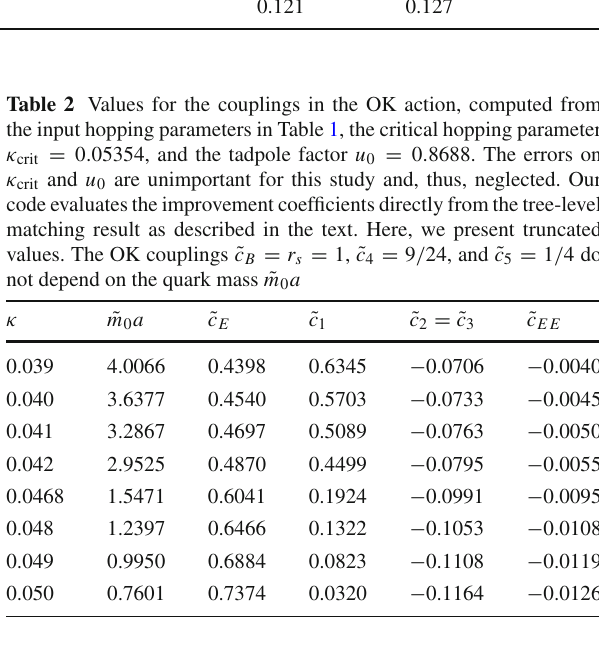
at this lattice spacing, falling in two regions, referred to as b -like and c - like, respectively. Vertically aligned values yield approximately equal